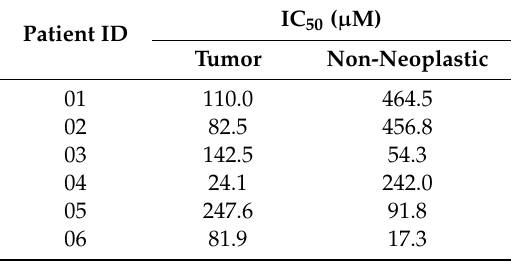
Figure 6. Effects of the 2,4-DAQ on cell viability of gastric cancer (GC) organoids. Organoids viability assay was performed to determine the growth inhibition values of 2,4-DAQ. ( A ) Dose–response of tumor-derived organoids and ( B ) nonneoplastic lesions-derived organoids proliferation to 2,4-DAQ treatment measured at 6 days. All data presented as mean ± SD, n = 3. Table 1. IC 50 values for 2,4-diamino-quinazoline for GC PDOs.